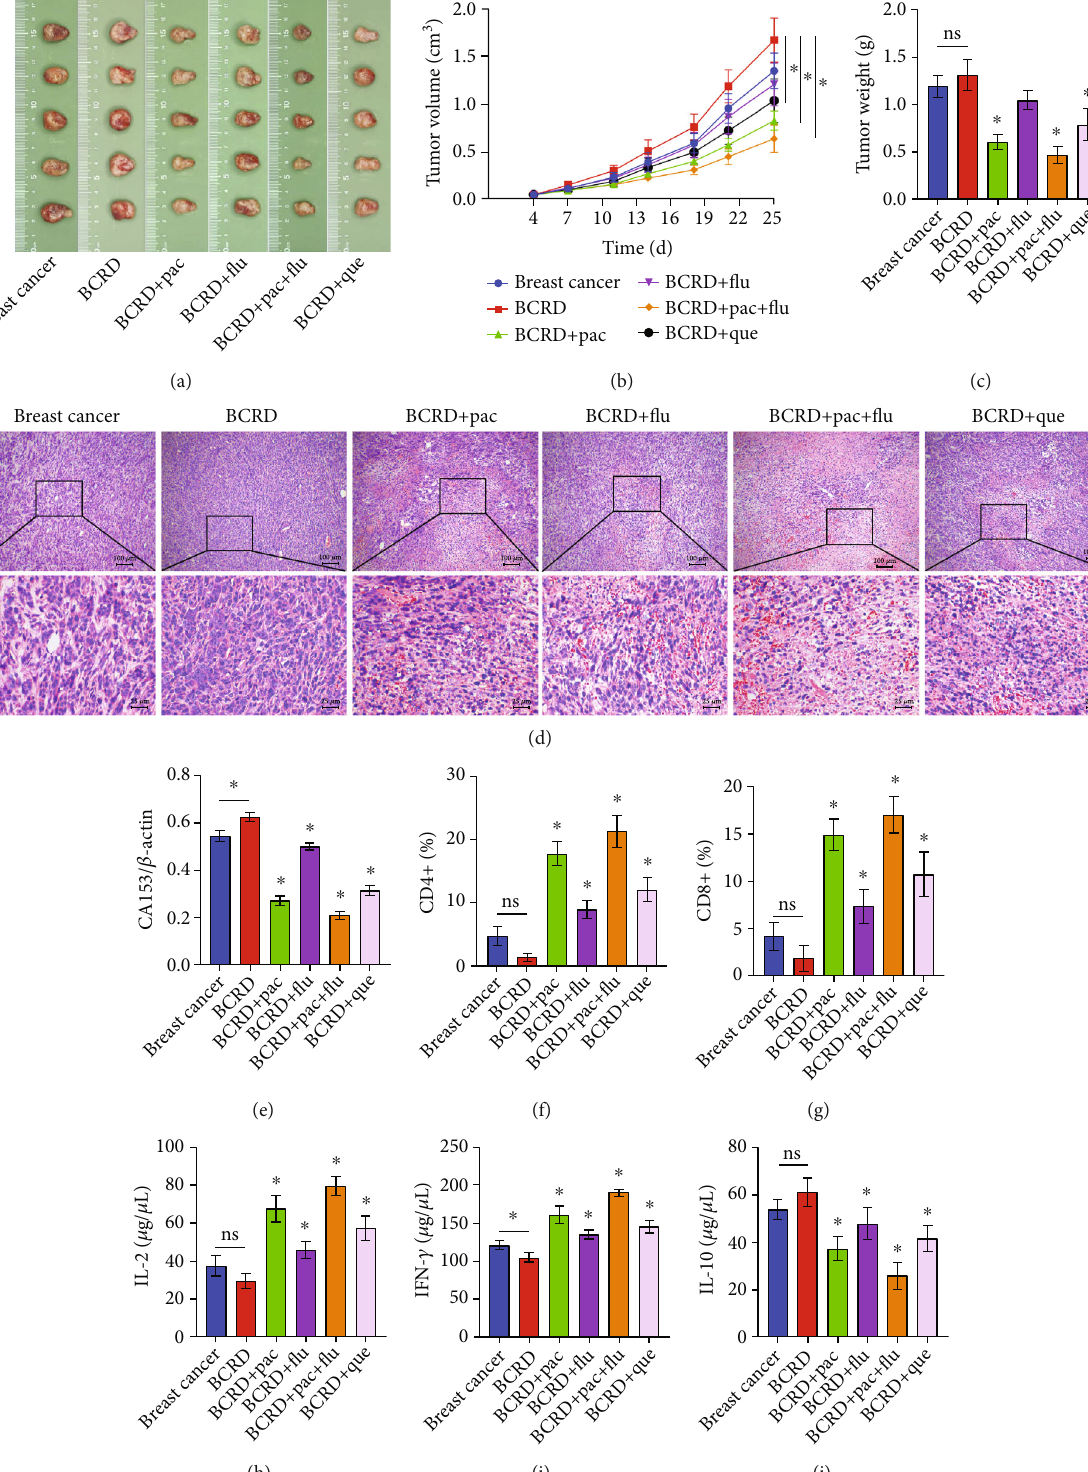
Figure 6: Quercetin promoted an anti-tumor immune response in BCRD mice. (a) The tumor tissues of mice were collected. (b) The tumor volume was calculated. (c) The tumor weight was recorded. (d) The histological change in mice was detected by H&E staining. (e) The expression of CA153 was assessed. (f, g) The ratio of CD4+ and CD8+ in mice was assessed by fl ow cytometry. (h – j) IL-2, IFN- γ , and IL-10 levels in mice were investigated by ELISA. ∗ p < 0 : 05 compared with breast cancer ( n = 6